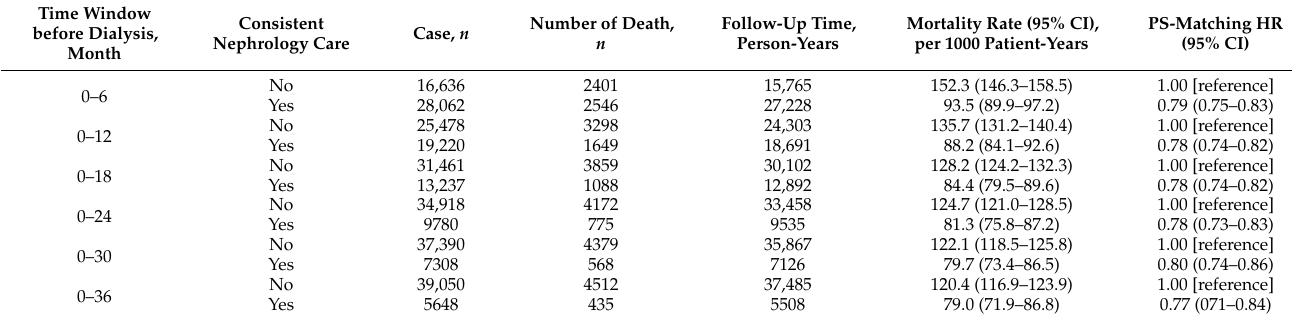
Table 3. Effects of consistent nephrology care at each time interval on one-year mortality after dialysis.